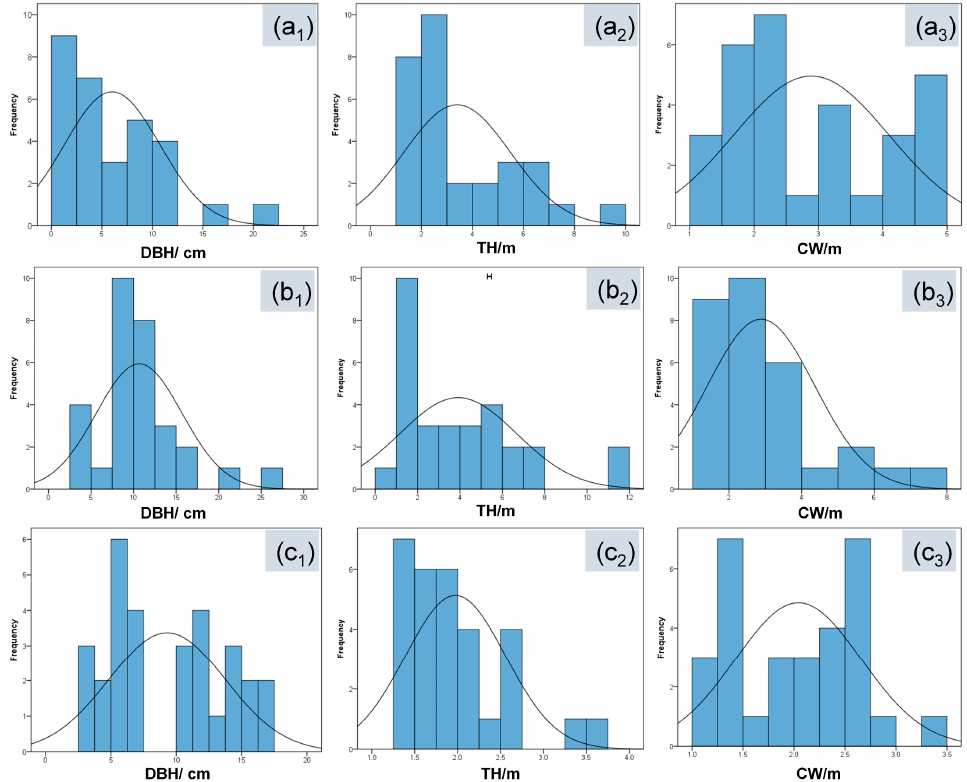
Figure 8. Nonspatial structure in MWLs. DBH, TH, and CW in the figure indicate the diameter at breast height (cm), tree height (m), and crown width (m), respectively (the same in the figure below); in addition, ( a 1 – a 3 ) indicate the BJ, ( b 1 – b 3 ) indicate the HJ, ( c 1 – c 3 ) indicate the SB.